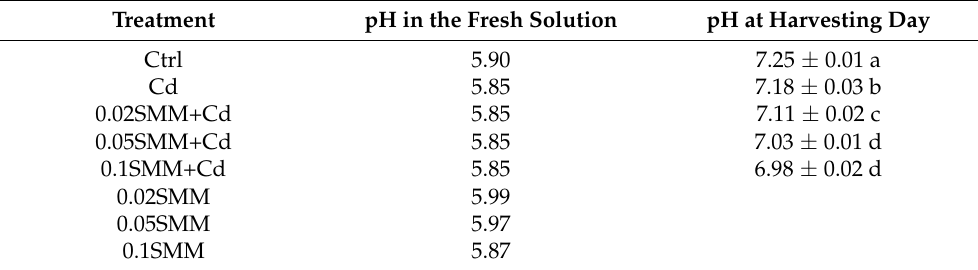
Table 1. pH values of the fresh bulk nutrient solution and after two weeks of 0.01 mM Cd treatment of Szarvasi-1 energy grass primed with 0.02, 0.05 and 0.1 mM SMM. Data are presented as mean ± SD. To compare the differences, one-way ANOVA was performed on the dataset with Tukey–Kramer post hoc test ( p < 0.05). Different lowercase letters indicate significantly different